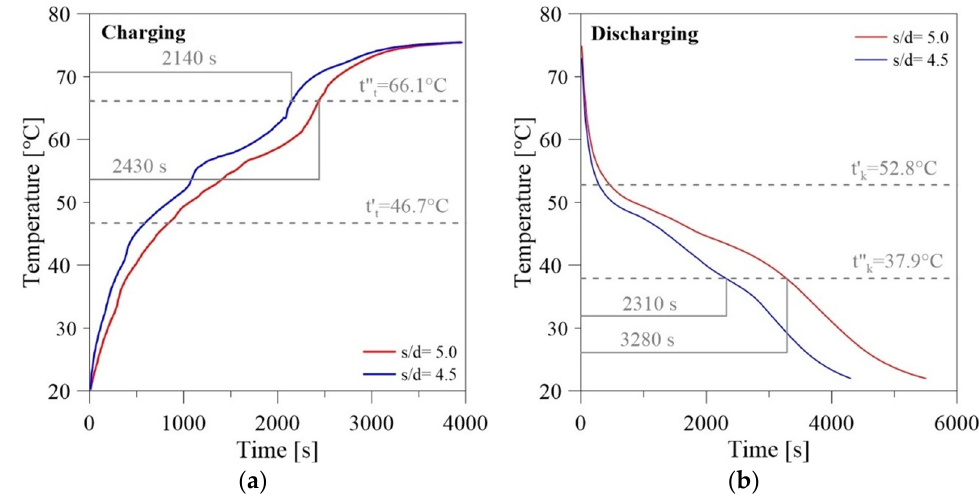
Figure 8. Effect of the pitch ratio for RT54HC: ( a ) charging, ( b ) discharging. The pitch ratio is the ratio of the distance between adjacent tubes to the outside diameter of the tube [34]. Hence, for a given diameter, a smaller pitch ratio means a smaller distance between adjacent tubes. As shown in Figure 8a,b, the time to reach the final melt- ing and solidification temperature is shorter for the smaller tested pitch ratio (blue lines).